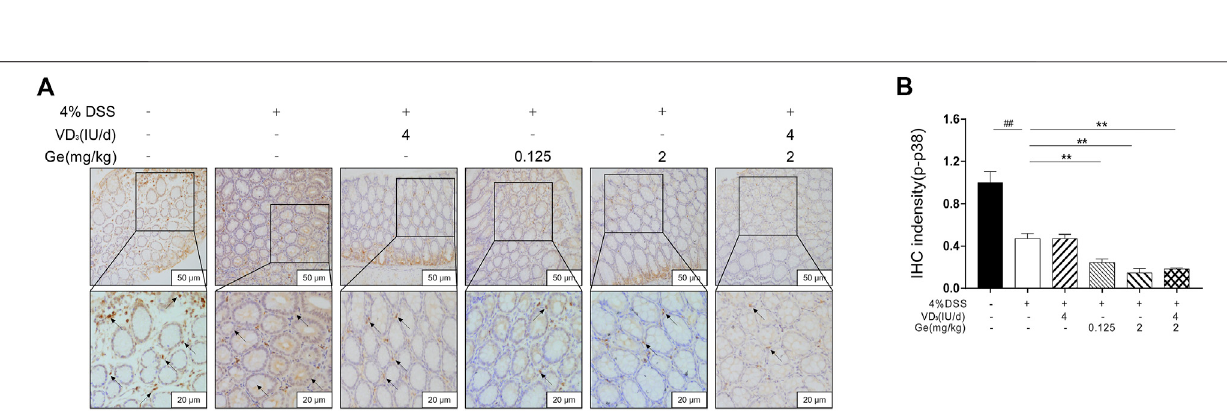
Frontiers in Pharmacology |